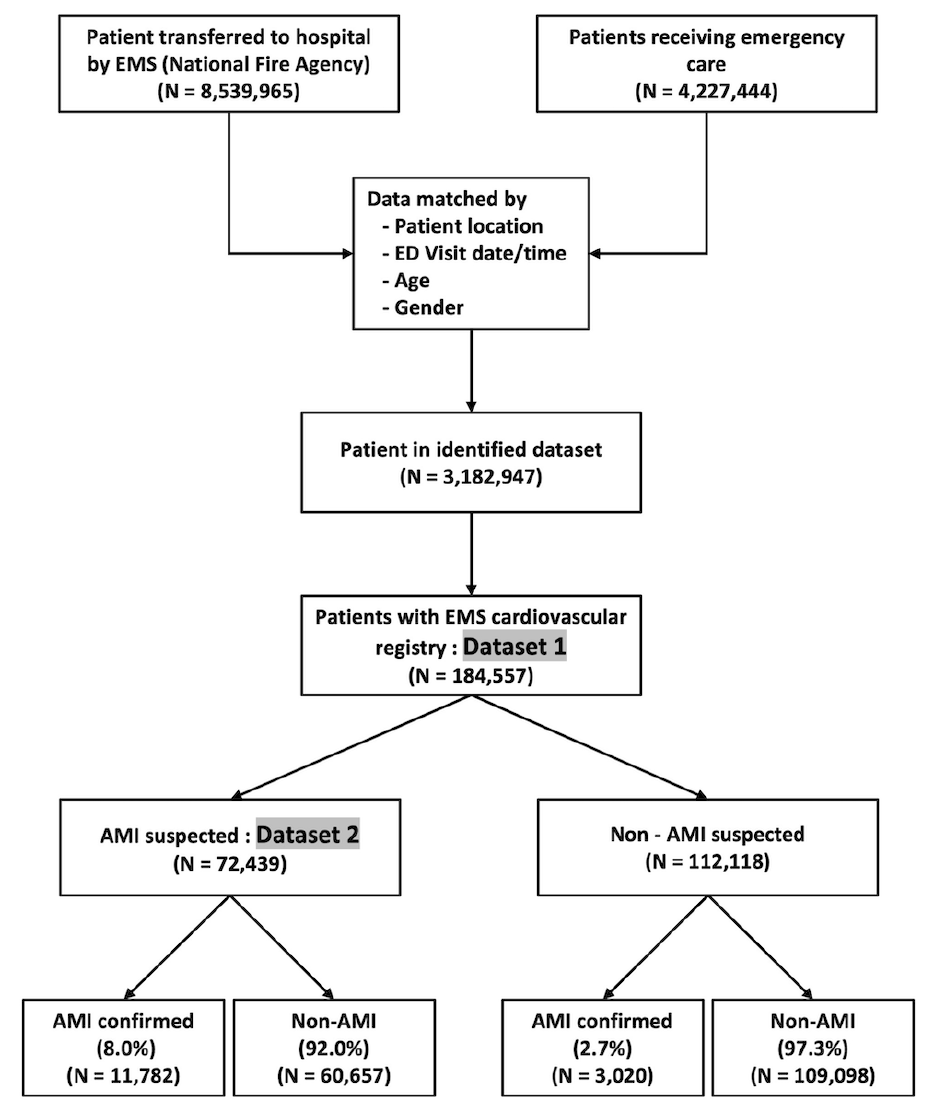
Figure 2. Flow chart of conducted study (EMS: emergency medical service; ED: emergency depart- ment; AMI: acute myocardial infarction). Table 1. Discrimination and test characteristics of acute myocardial infarction prediction